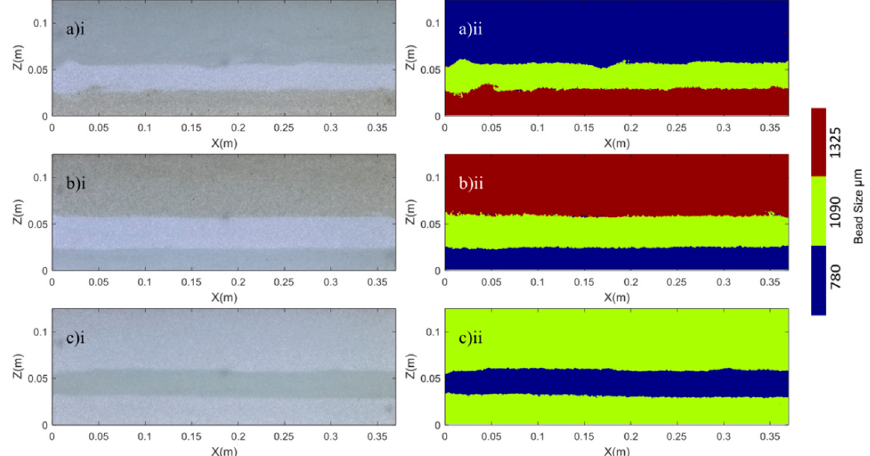
Figure 6. Heterogeneous aquifers (i) ( a ) Layered1, ( b ) Layered2, ( c ) Layered3 and (ii) bead structure generated by a multi-layered Artificial Neural Network (ANN).